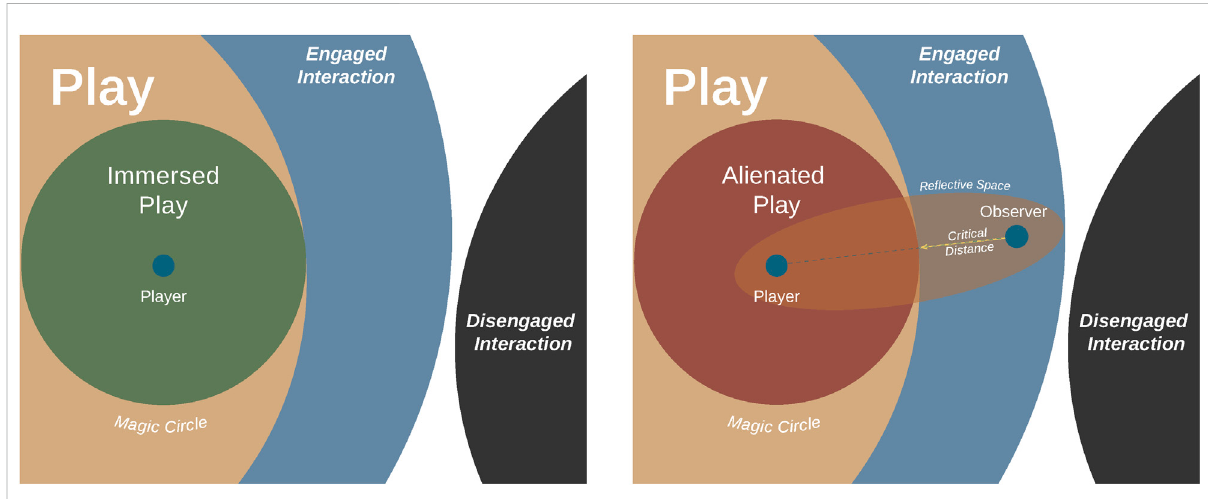
FIGURE 1 A visual representation of the two conceptual models of immersed and alienated play, extrapolating on the metaphors of space in regards to play and re fl